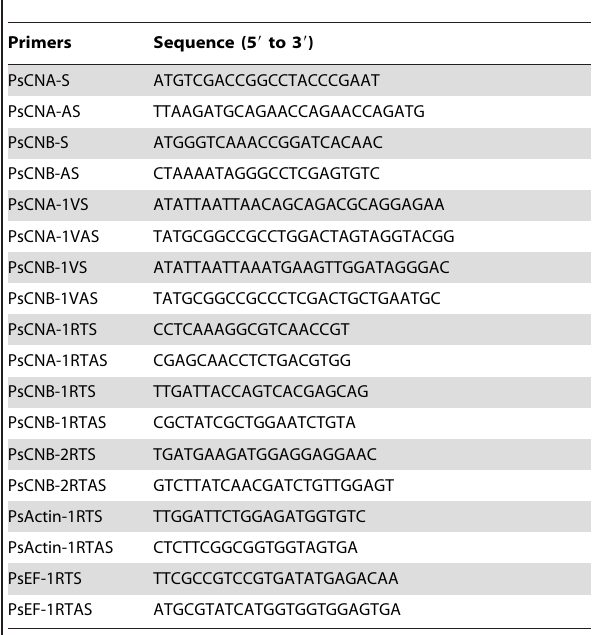
Table 3. Primers used in this